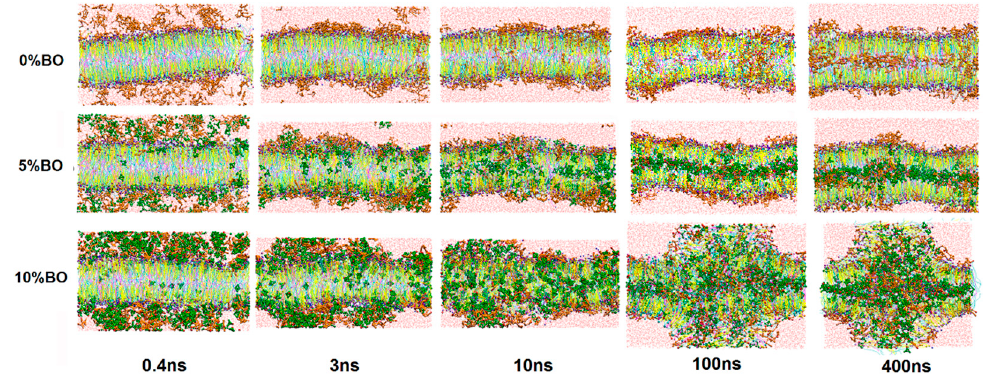
Figure 4. Morphology evolution of lipid bilayer systems with time at different concentrations of borneol by CG-MD simulations. The concentration of osthole was fixed at 10%.